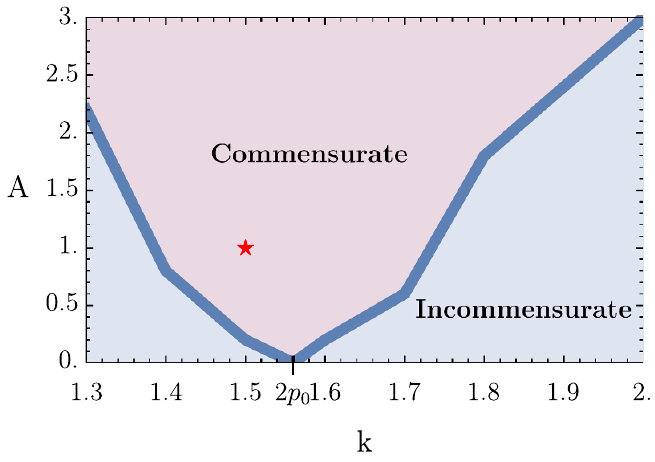
Figure 7 . Phase diagram showing the minimal amplitude of the lattice, which leads to the com- mensurate lock-in between the spontaneous stripe and the lattice. The range of k corresponds to the (cid:12)rst order lock-in, which is seen most clearly in our data. The red star shows the solution depicted in (cid:12)gures 8 and 9